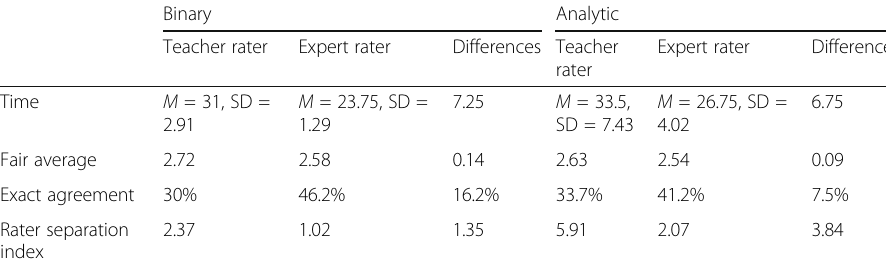
Expert rater Differences rater